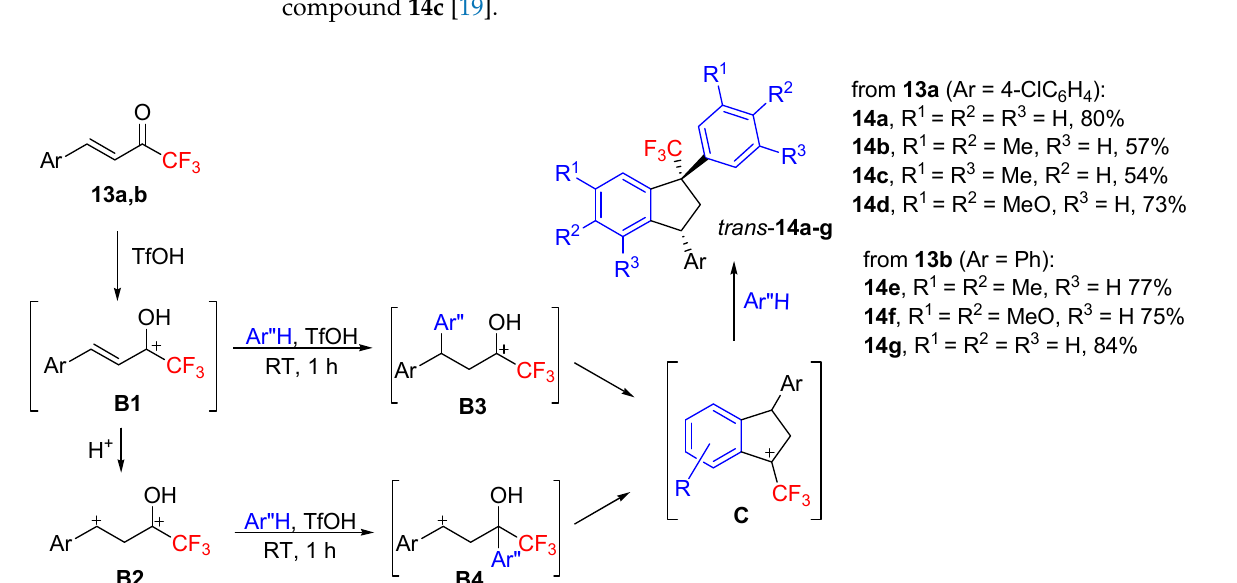
Scheme 8. Stereoselective synthesis of trans- 1-CF 3 -indanes 14a-g from CF 3 -enones 13a,b and arenes in